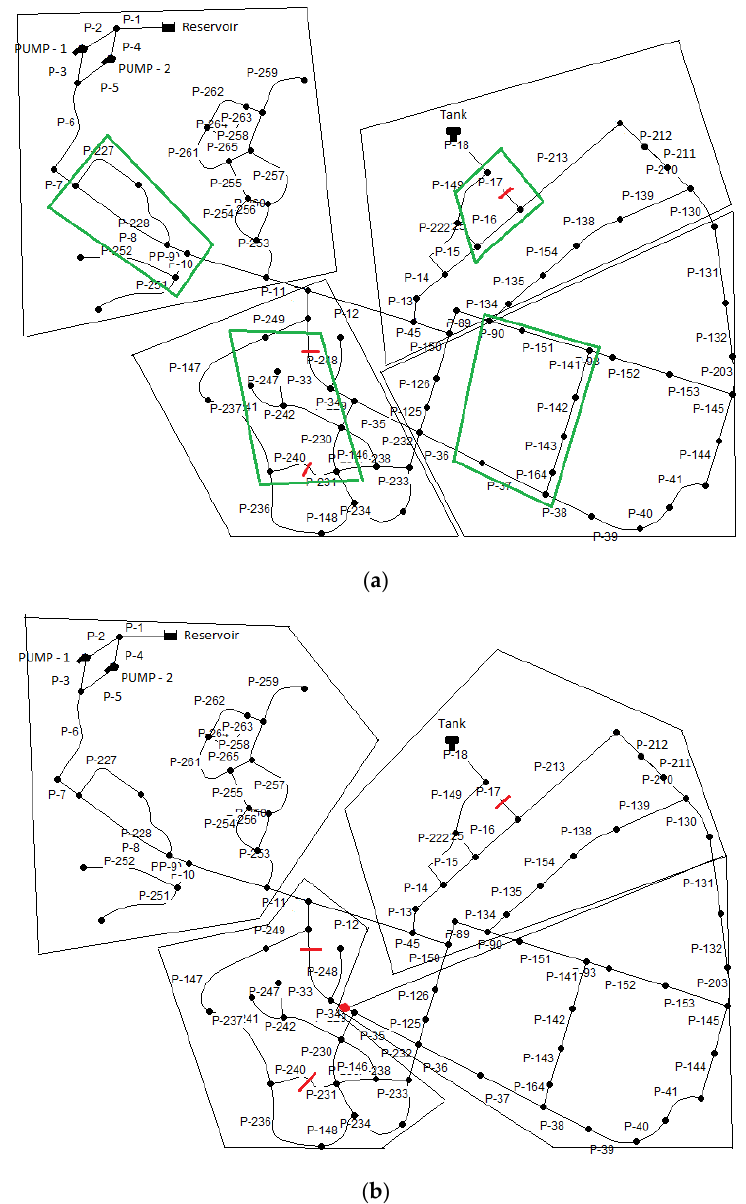
Figure 7. ( a ) The clusters with the highest average value for each sub-region using SMM-EM (green contour) and the pipes in which isolating valves are installed (red), ( b ) the division of the network in DMAs and the selected pipes for PRV installation (red circle).